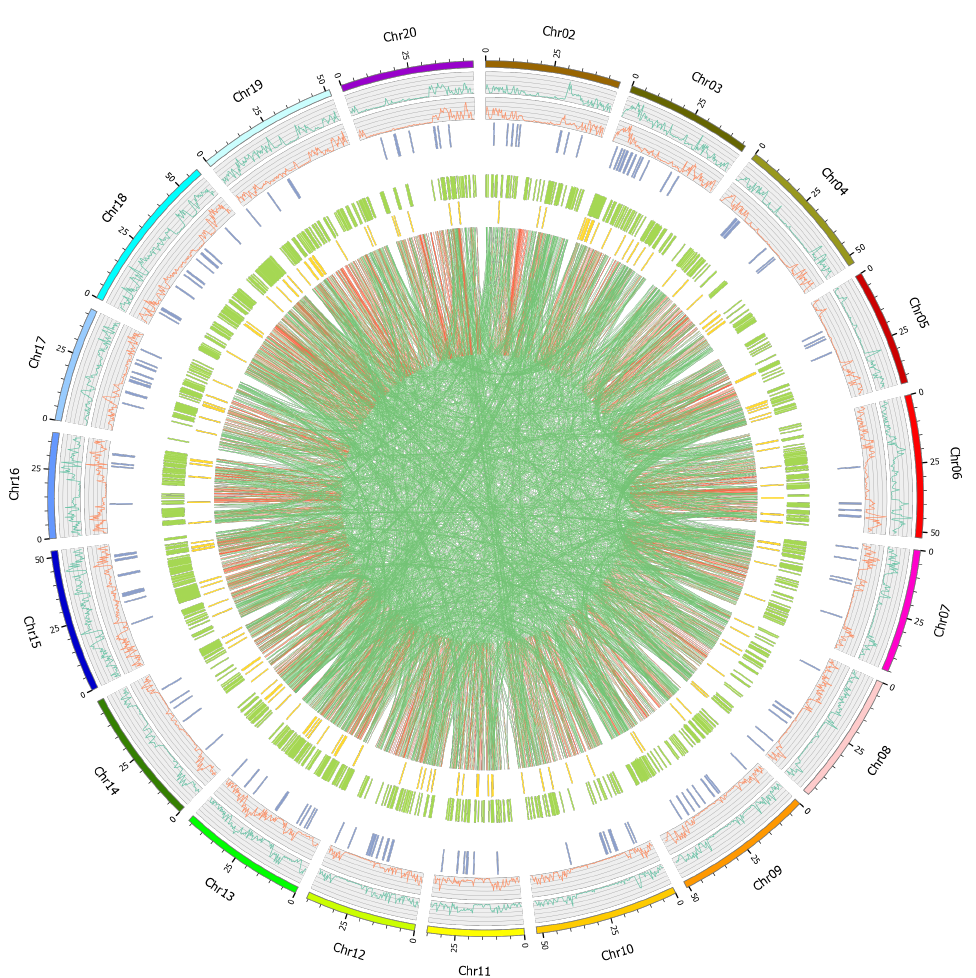
Figure 3. The distribution of the variations of Taiwan-75 on the chromosomes. The order from outside to inside: Chromosome, SNP distribution, InDel distribution, CNV, SV (INS, DEL, INV, ITX (red line), CTX (green line)) distribution (Unit